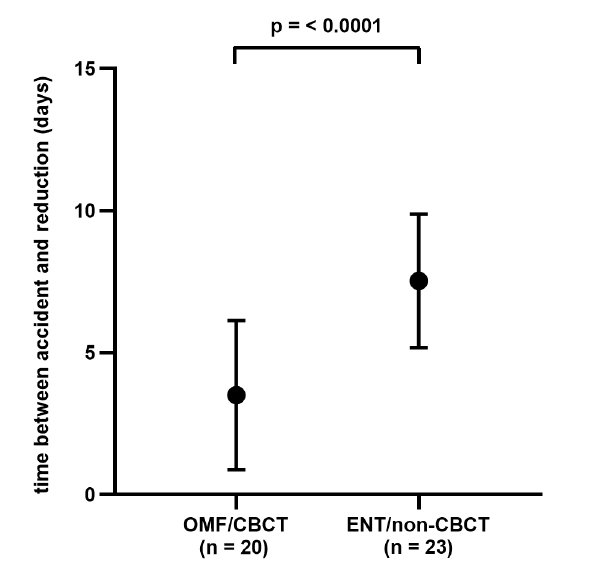
Figure 5. Comparison of the elapsed time between the accident and the closed reduction of the nose between the OMF/CBCT group and the ENT/non-CBCT